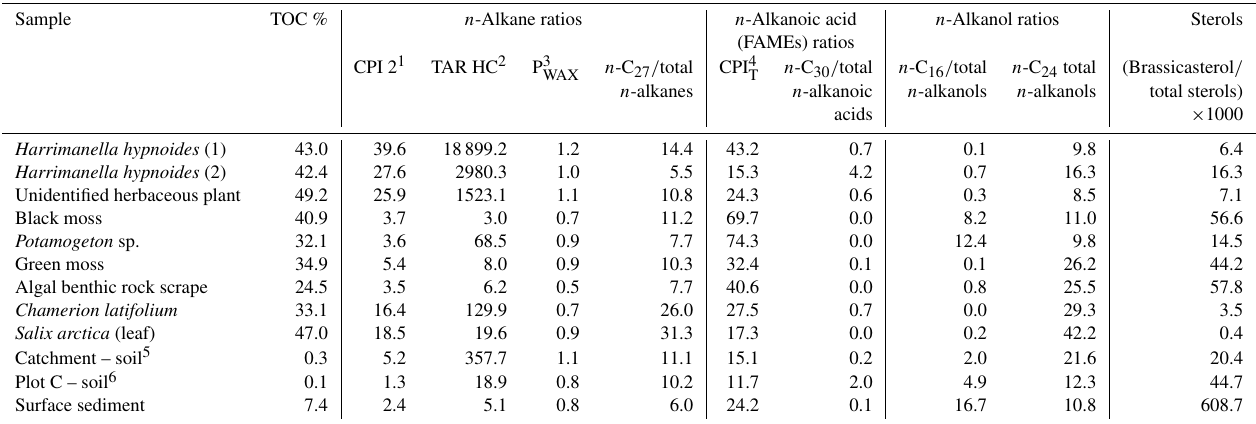
Table 4. Selected lipid ratios for catchment samples from Disko 2 analysed using GC–MS. Sample TOC % n -Alkane